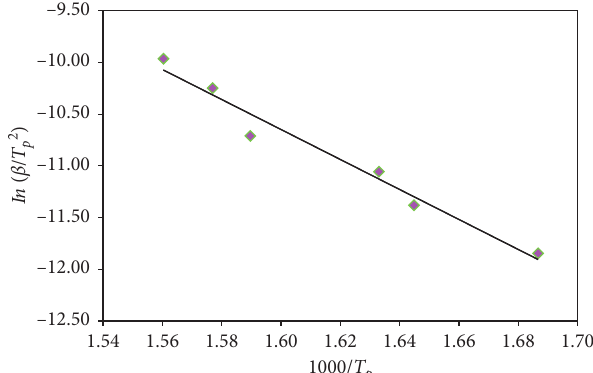
) versus 1000/ T p for sample p